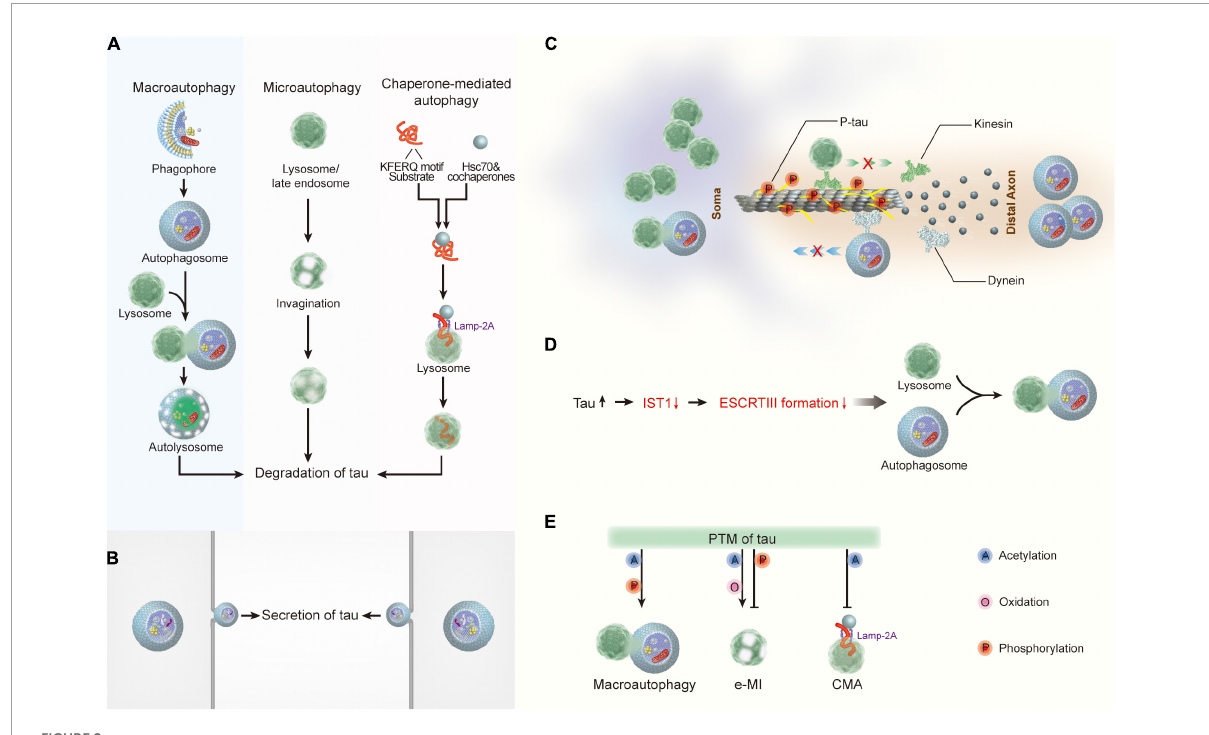
FIGURE2 The crosstalk between tau and autophagy. (A) Macroautophagy, microautophagy, and chaperone-mediated autophagy are involved in tau degradation in neurons. (B) Tau protein can be secreted via the autophagy-based unconventional secretory pathway. (C) Pathological tau reduces its binding affinity to microtubules, thereby leading to microtubule depolymerization and the impairment of both the degradative lysosome transportation to axons and the retrograde transport of autophagosomes to lysosomes. (D) Tau accumulation disrupts autophagosome-lysosome fusion via inhibiting IST1 expression and disrupting ESCRT-III complex formation. (E) Post- translational modifications of tau regulate its degradation by autophagy. Hsc70, heat shock cognate 70; Lamp-2A, lysosome-associated membrane protein type 2A; ESCRT, the endosomal sorting complex required for transport; IST1, IST1 factor associated with ESCRT-III; e-MI, endocytic microautophagy; CMA, chaperone-mediated